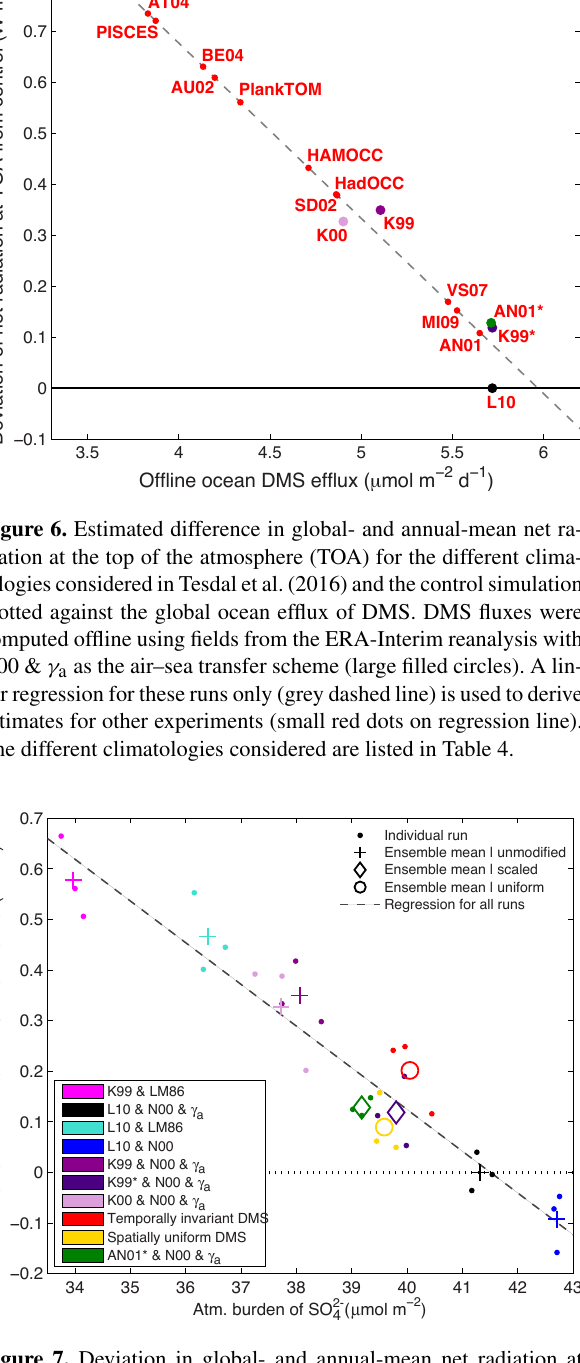
Figure 7. Deviation in global- and annual-mean net radiation at TOA from control plotted against the global- and annual-mean at- mospheric burden of SO 2 − . Symbols are as in Fig. 5. All data points 4 are used for the linear regression (grey dashed